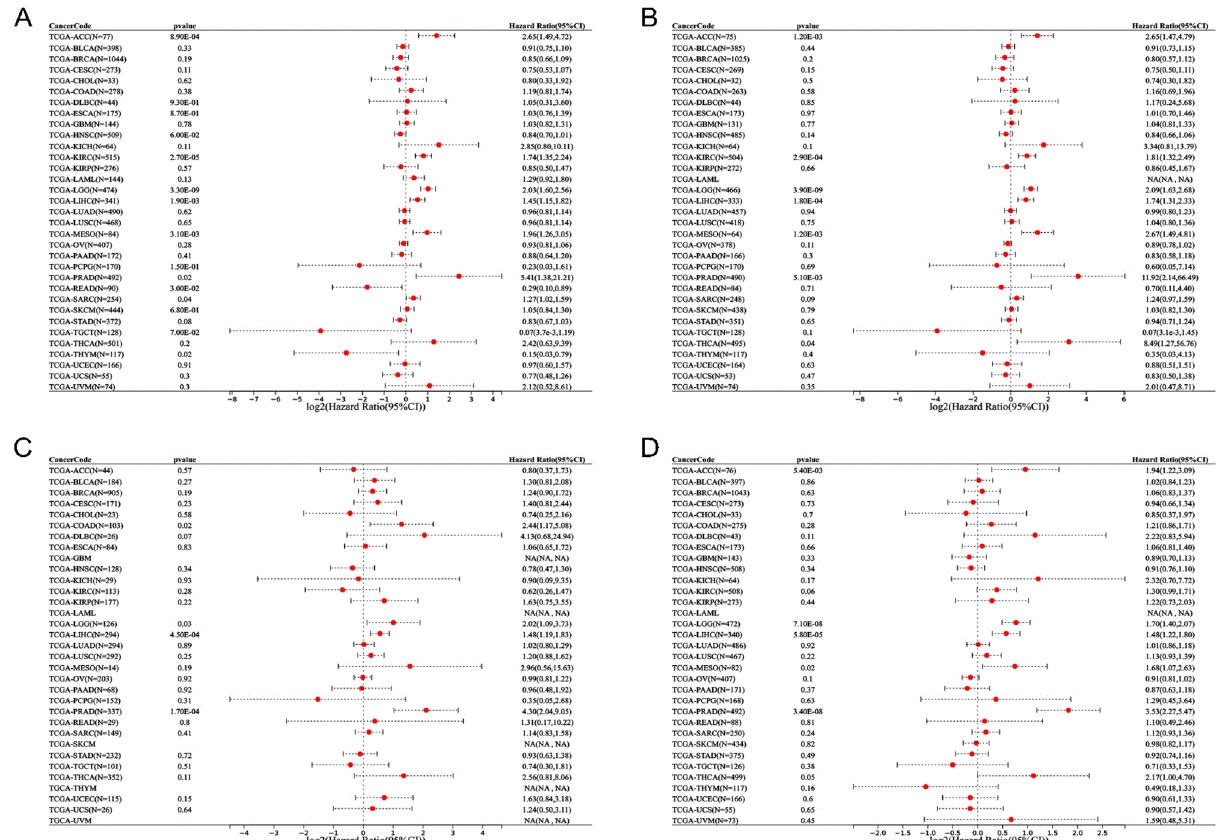
Figure 2. Forest plots of survival analysis based on HAUS5 expression in 33 types of tumors based on the SangerBox database. ( A ) ACC, KIRC, LGG, LIHC, MESO, PRAD, READ, SARC and THYM patient OS showed a significant correlation with HAUS5 expression. ( B ) HAUS5 expression is significantly related to DSS in ACC, KIRC, LGG, LIHC, MESO, PRAD and THCA. ( C ) The forest plot indicates that COAD, LGG, LIHC and PRAD patient DFI values are significantly related to the expression of HAUS5. ( D ) ACC, LGG, LIHC, MESO and PRAD patient PFI values are significantly related to HAUS5 expression. OS, overall survival; DFI, disease-free interval; DSS, disease-specific survival; PFI, progression-free